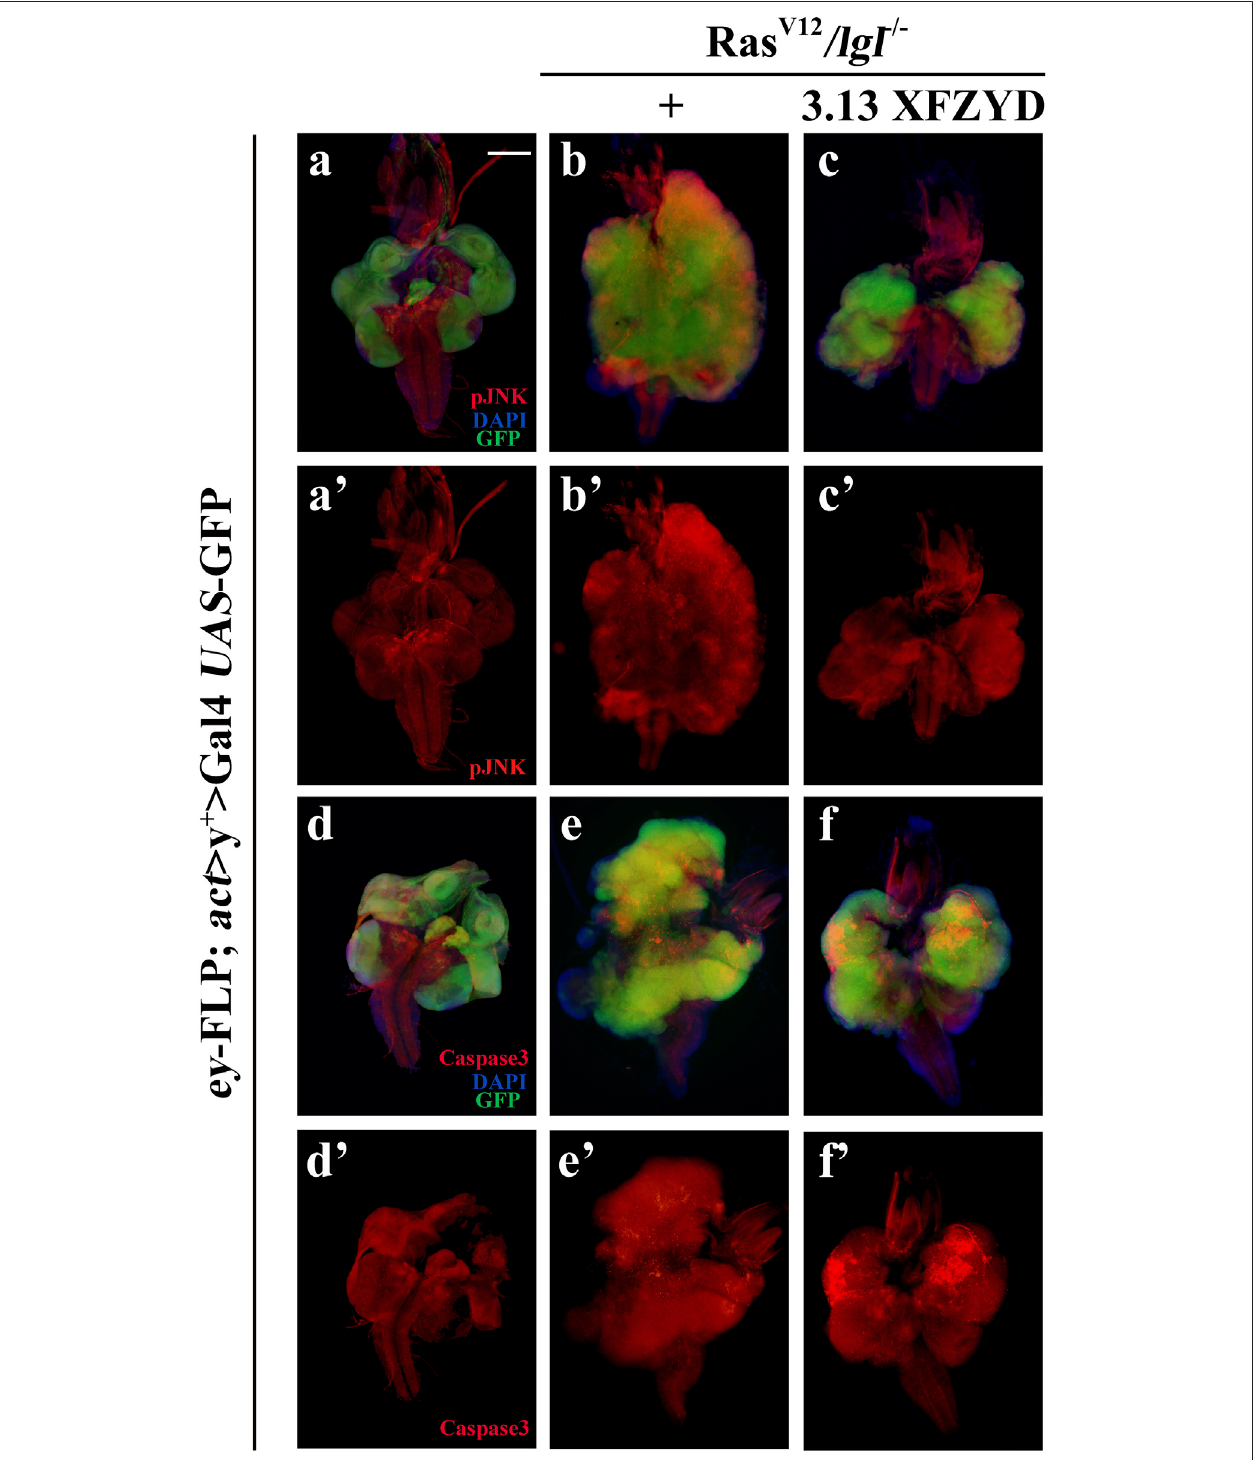
FIGURE 7 | XFZYD alters pJNK and Caspase3 expression. Merged fl uorescence micrographs of 3 rd instar larval cephalic complexes (A – F) are shown. The individual channels detect only pJNK [red, (A ’– C ’ ) ] or only cleaved-Caspase3 signal [red, (D ’– F ’ ) ]. Tumour cells are marked with a green fl uorescent protein (GFP), and nuclei (DNA) are labelled with DAPI (blue). Scale bar: 200 µm (A – F) .